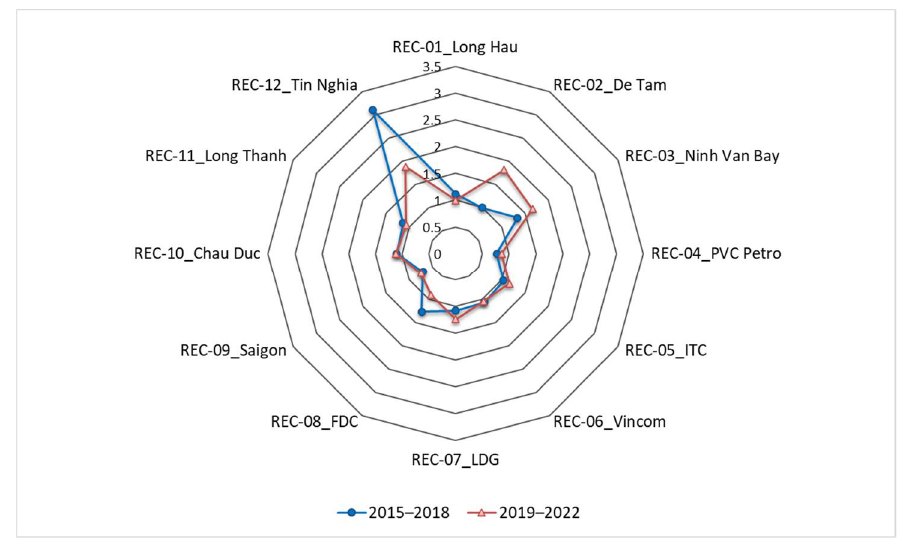
Figure 11. Two-side productivity evaluation comparison.